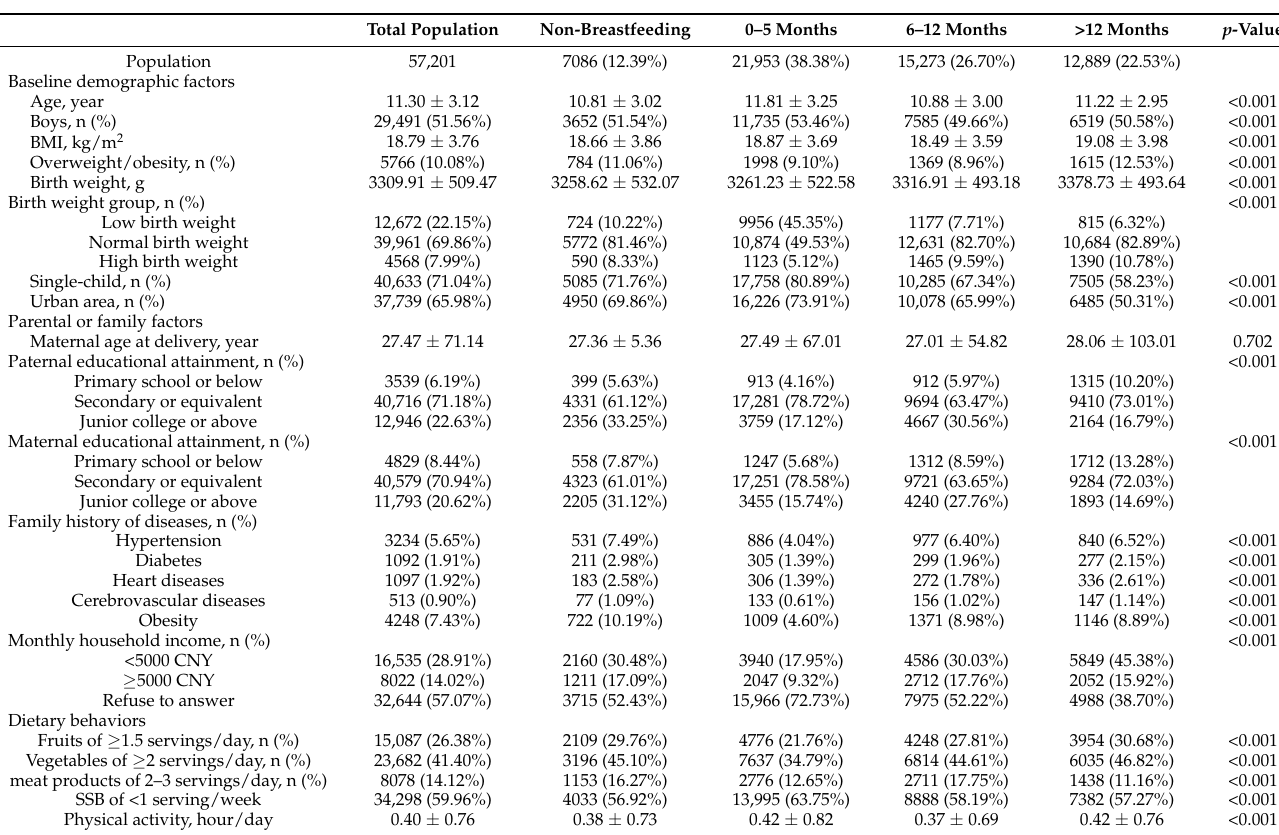
Table 1. Baseline characteristic of included sample divided by breastfeeding duration in boys and